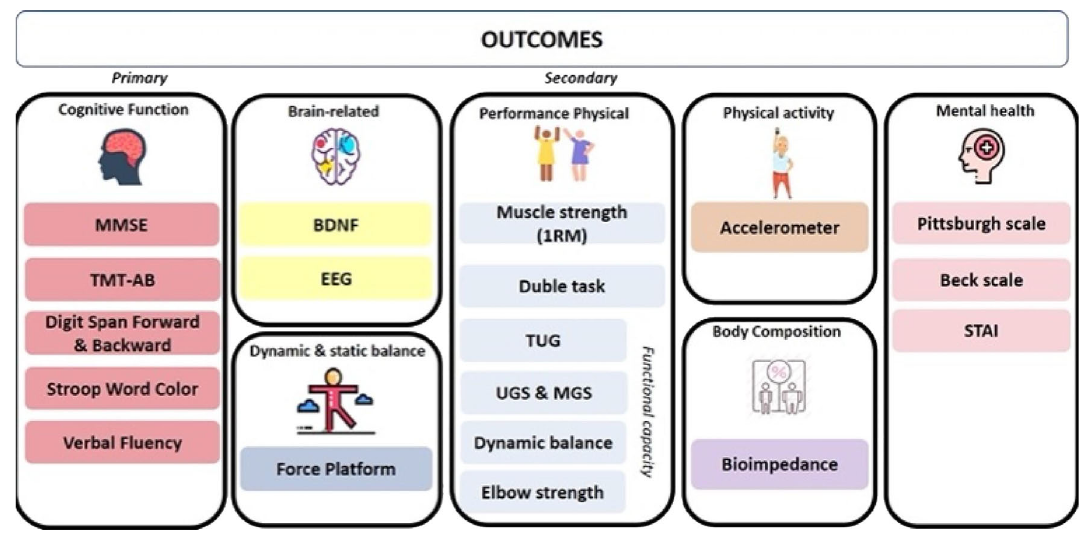
Figure 2 - Study outcomes summary. MMSE: Mini-Mental State Examination; TMT: Trial Making Tests; BDNF: Brain-derived neurotrophic factor; EEG: electroencephalogram; 1-RM: one maximal repetition test; TUG: timed up and go; UGS: usual gate speed; MGS: maximum gate speed; STAI: State-Trait Anxiety